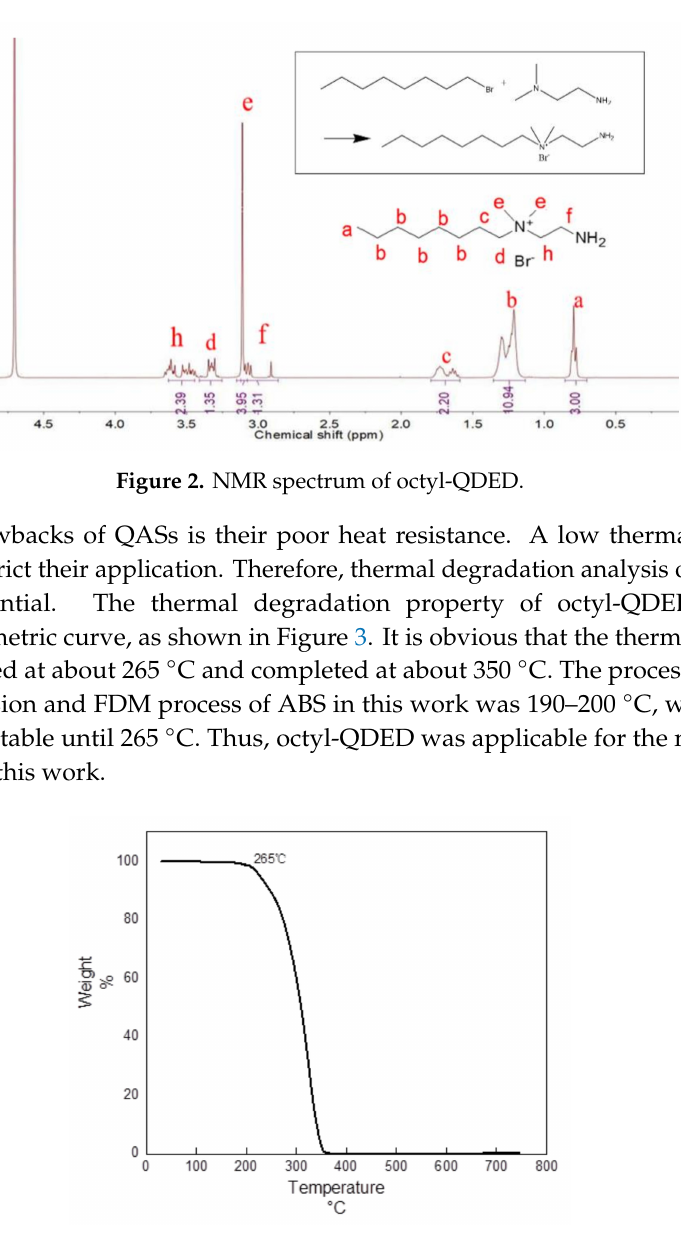
Figure 3. Thermogravimetric curve of